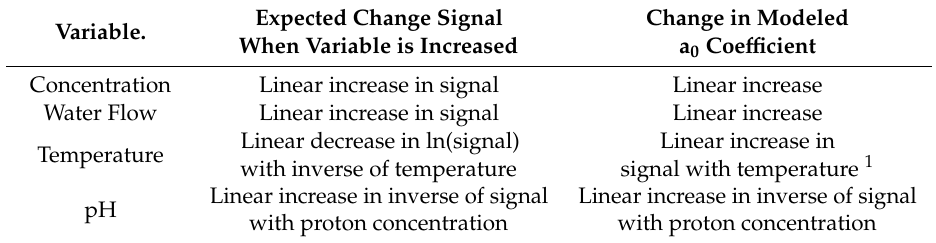
Table 1. Relationship between variables and both the expected theoretical signal and the modeled a 0 coe ffi cient. Variable. When Variable is